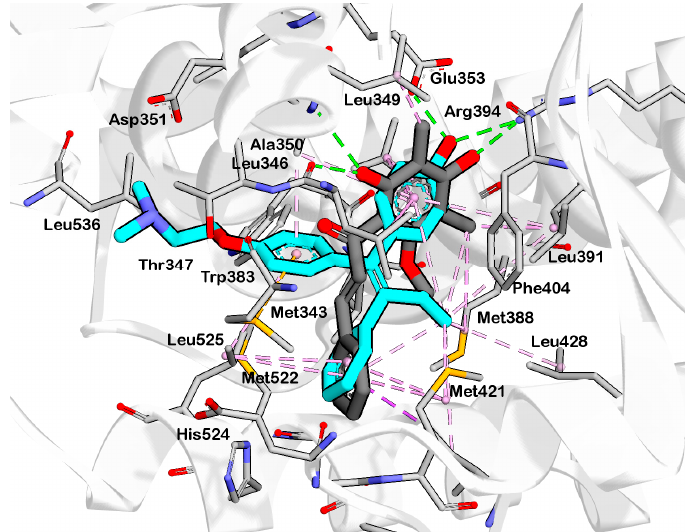
Figure 4. Overlay of the docked pose of ChalcEA (gray) and 4-hydroxy-tamoxifen (4-OHT) (blue) in the binding site of estrogen receptor alpha (ER α ). Hydrogen bond and pi-alkyl interactions are represented in green and pink colored dashed lines, respectively.